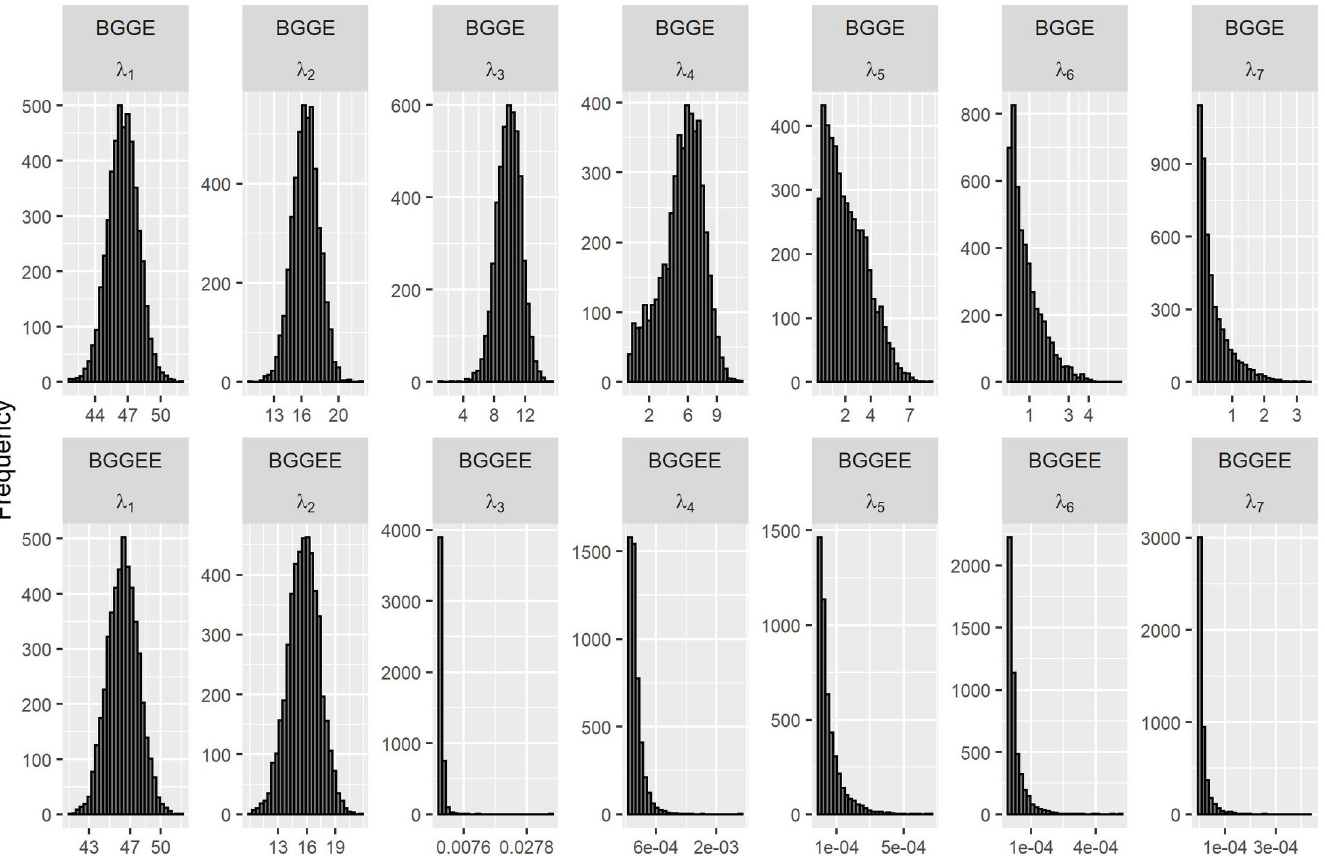
Fig 1. Histograms of the posterior marginal distributions of singular values, considering models of the complete dimensions for the proposed BGGE and BGGEE models.